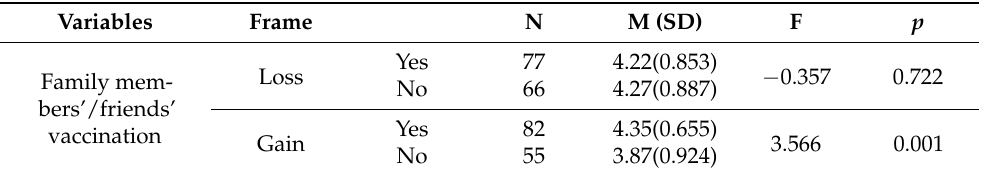
Table 5. Effect of family members’/friends’ vaccination on vaccination intention.